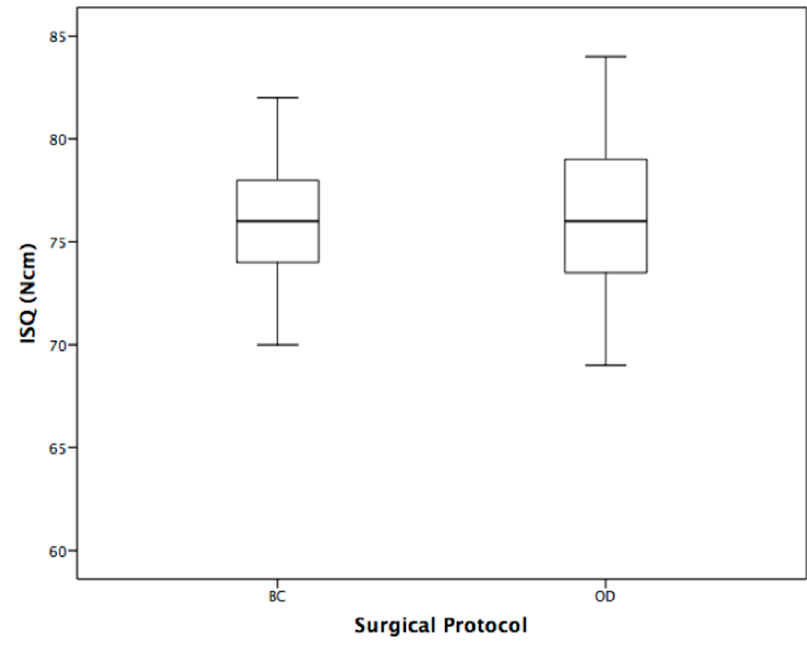
Figure 4. Box plot—implant stability quotient (ISQ). Figure 4. Box plot—Implant stability quotient (ISQ). Figure 4. Box plot—Implant stability quotient (ISQ).